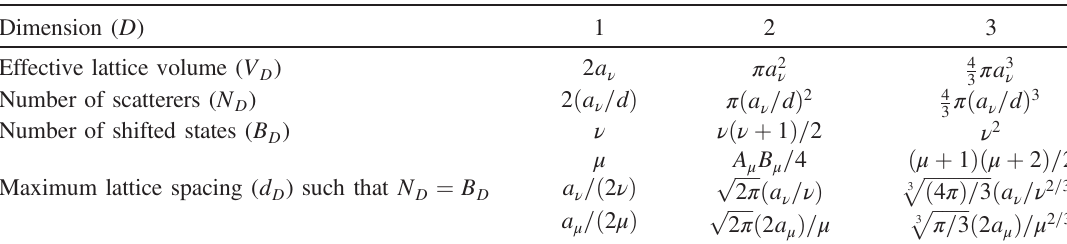
TABLE I. Scaling properties for the Rydberg composite (when the principal quantum number ν is used) or the SQD composite (when μ is used) in terms of the effective system radius, a ν ¼ a ν 2 or a μ ¼ a ½ð 3 þ 2 μ Þ = ω (cid:2) 1 = 2 . Note that A μ ¼ B μ ¼ μ þ 1 when μ is an even integer, and A μ ¼ μ þ 1 , B μ ¼ μ þ 3 when μ is odd. Where unspecified, the corresponding expressions for a SQD composite with principal quantum number μ are obtained by replacing ν → μ ; see Sec. II D. Dimension ( D